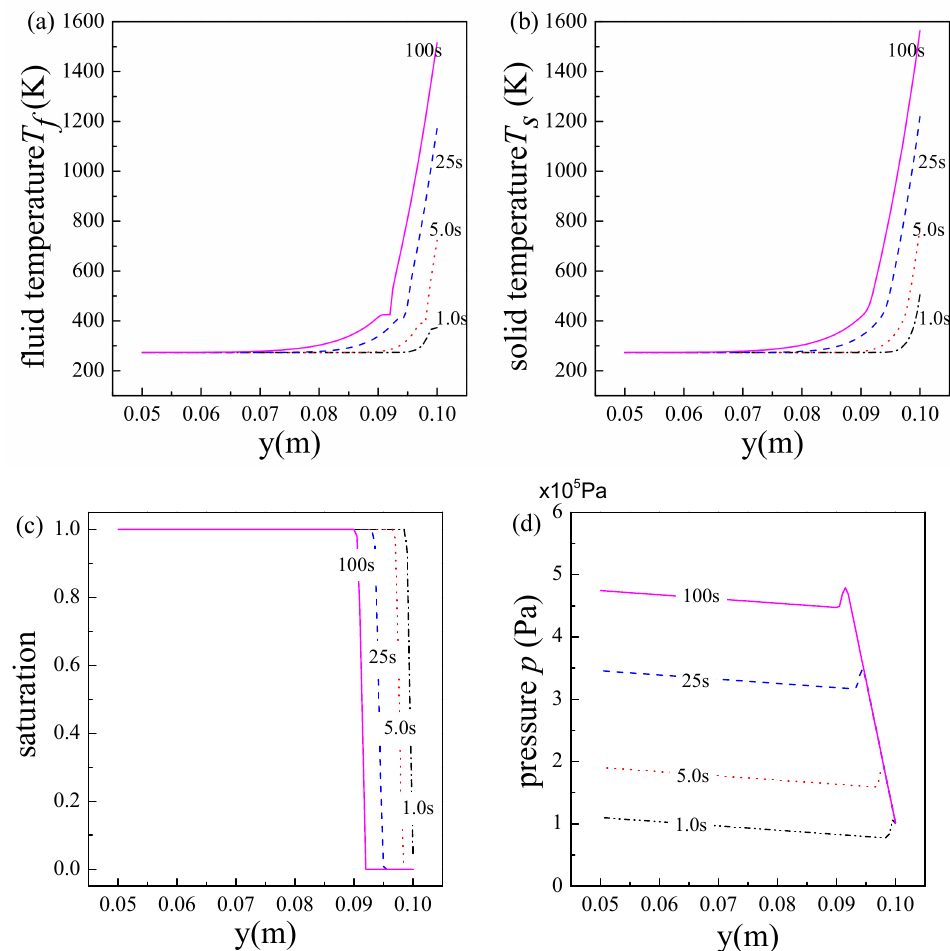
Figure 4. The distributions of ( a ) solid temperature, ( b ) fluid temperature, ( c ) fluid saturation and ( d ) fluid pressure within porous matrix in the initial stage.